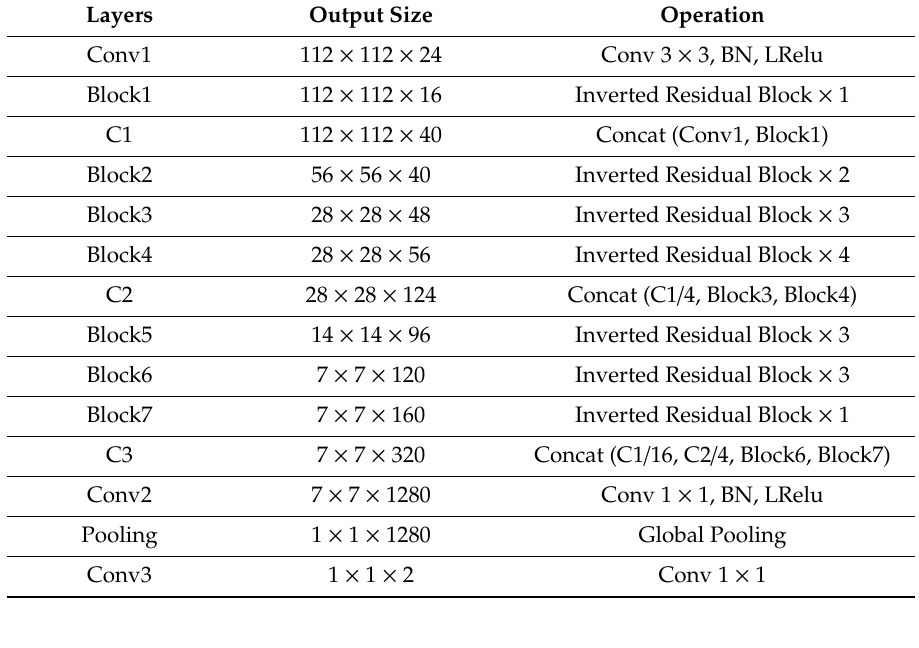
Table 1. Mobilenet-v2-Dense configuration. (“Conv” and “Concat” denote convolution and concatenation, respectively).